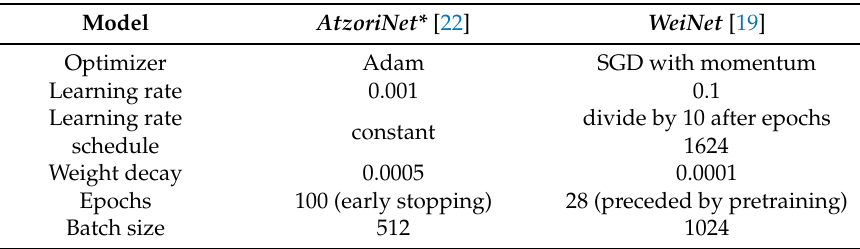
Table A2. Hyper-parameters used for the optimization of the CNN models.